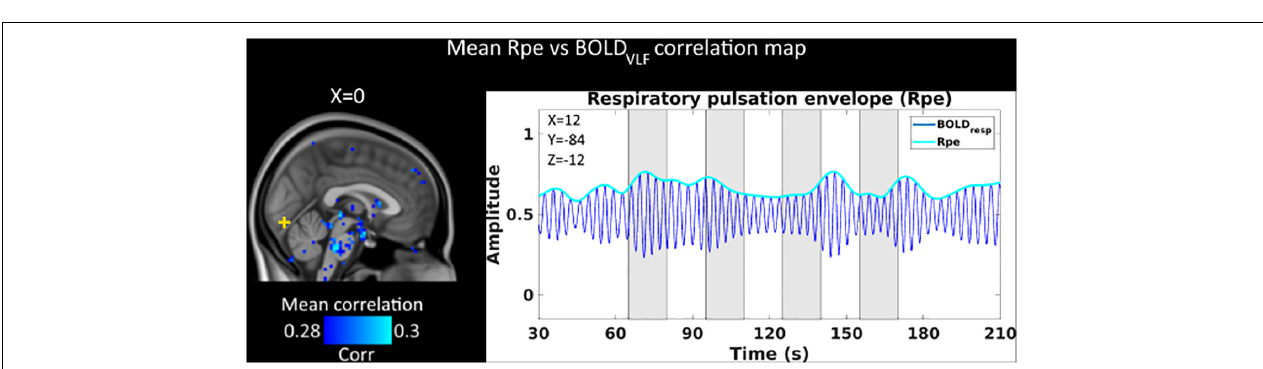
FIGURE 3 | Group average ( n = 23) amplitude, 1st column: BOLD VLF amplitude map (relative percentage map), 2nd column: CHe amplitude map focusing near the posterior V1 area, in proximity to the draining sagittal sinus. 3rd column: Lag between BOLD VLF and CHe voxel time-series. 4th column: Statistical significance ( p < 0.05) of correlation values between BOLD VLF and CHe voxel time-series within visual areas.